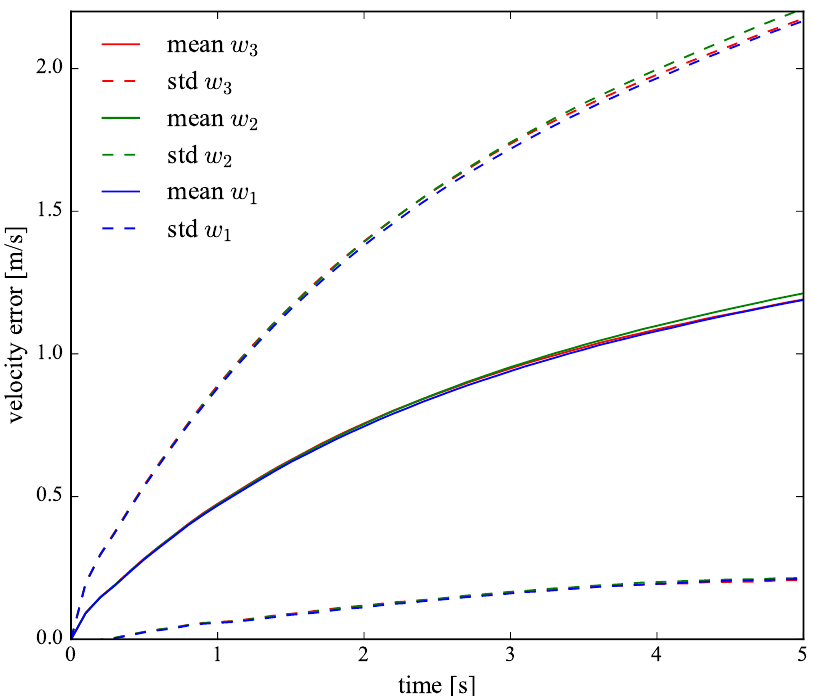
Figure 7. Statistics of velocity prediction errors. The solid and dotted lines are the means and standard deviations (std) of velocity prediction errors, respectively. The red corresponds to the nonlinear IDW method w 3 ; the green corresponds to the AW method w 2 ; the blue corresponds to the linear IDW method w 1 . The IDW methods (red and blue) are slightly better than the AW method